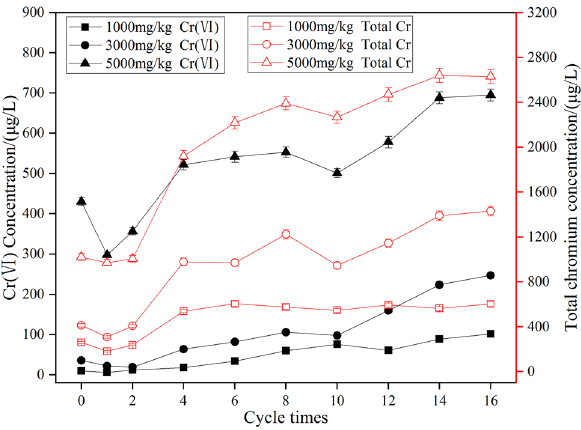
Figure 2. Effect of drying–wetting cycle timeson leaching concentration of